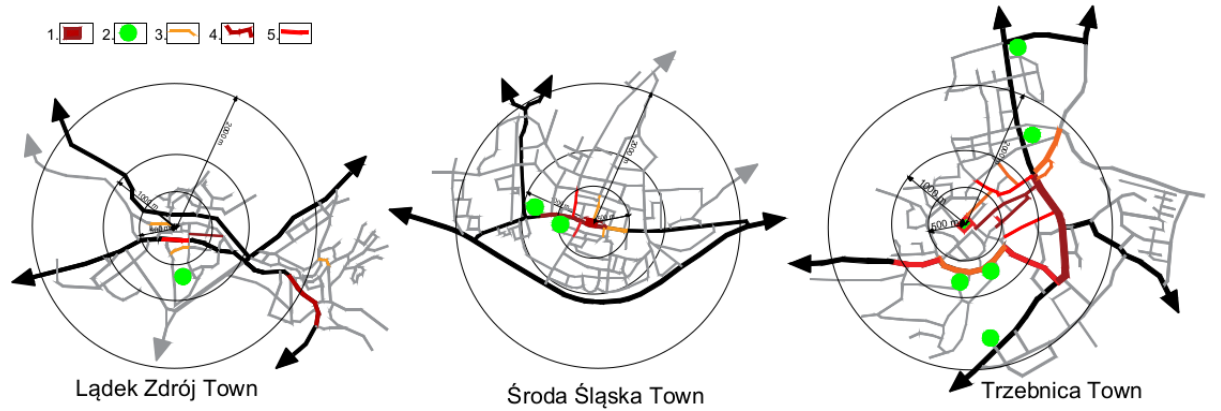
Figure 6. Commercial streets in small towns, 1—market square; 2—discount shop; 3–5—streets with the highest level of commercial activity.